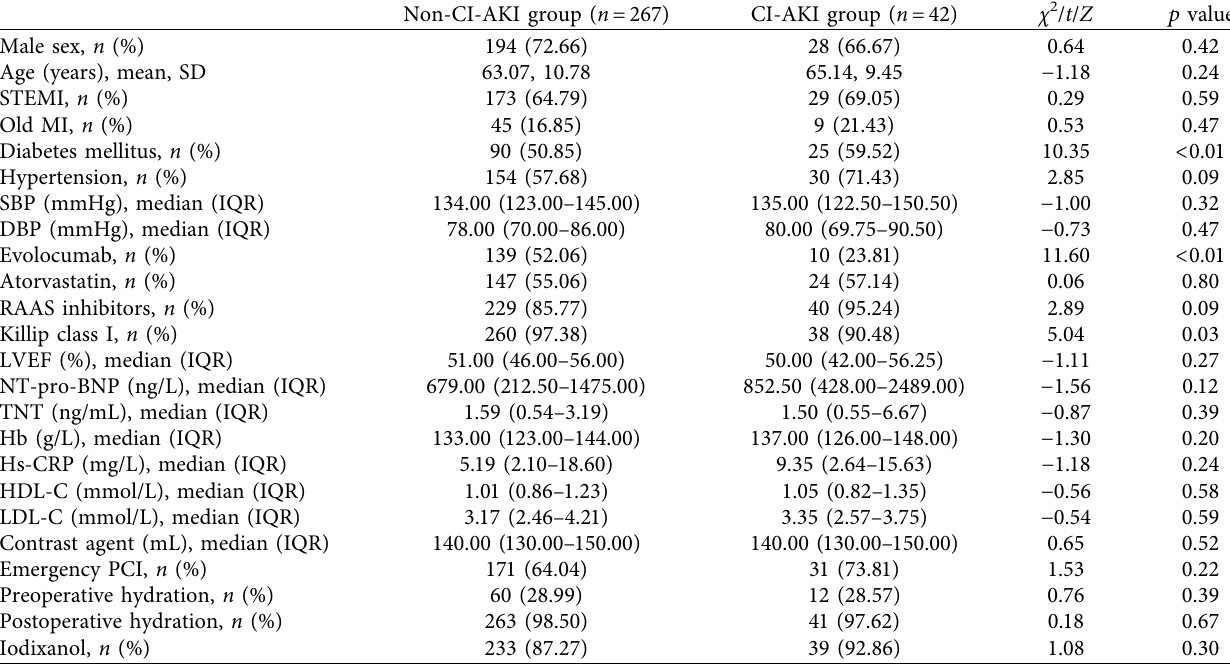
Table 3: Comparison of baseline data between the CI-AKI and non-CI-AKI groups.